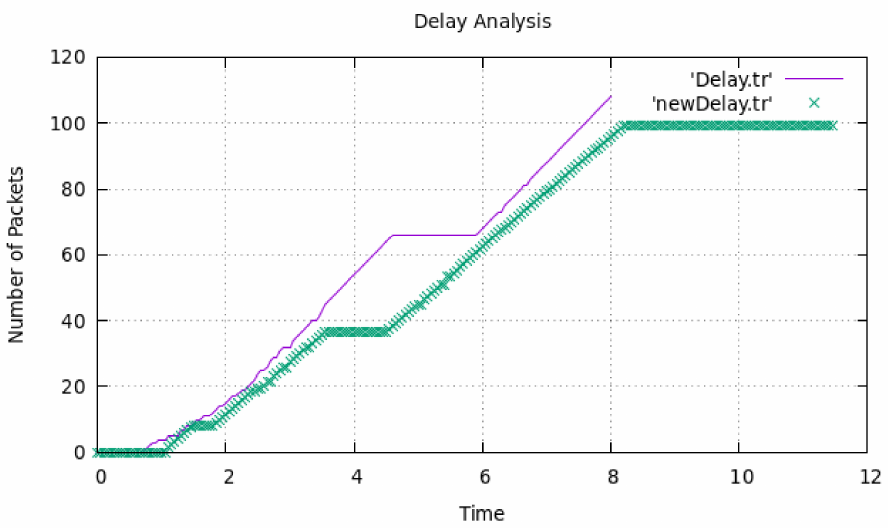
Figure 10. Delay analysis of flying